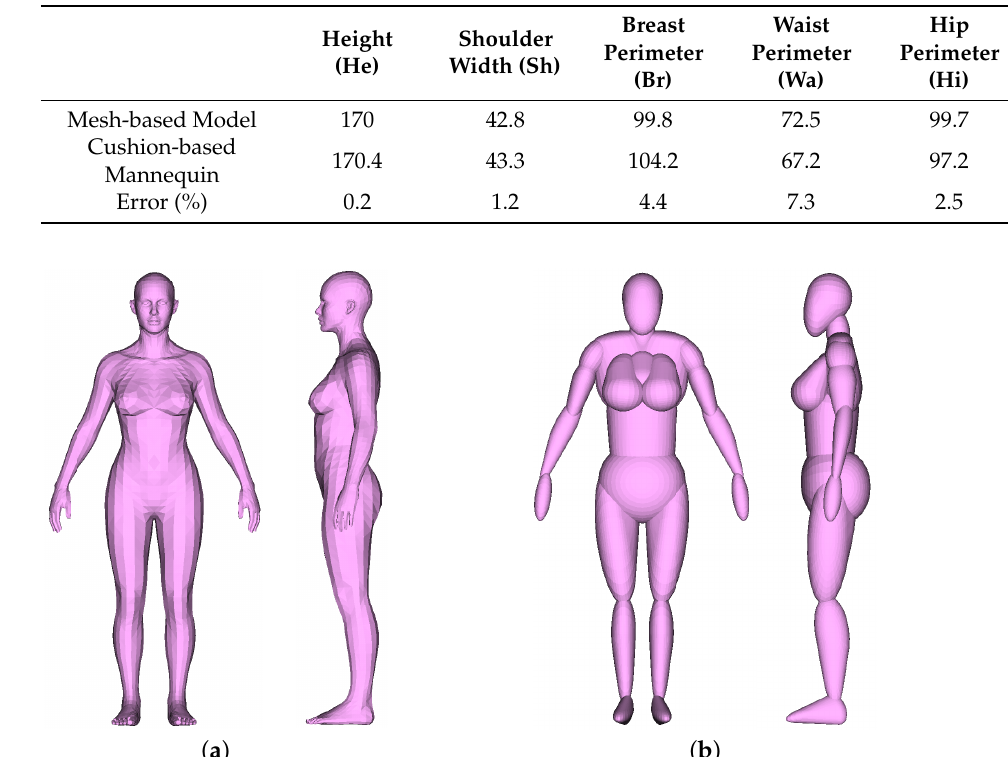
Figure 20. Visual comparison of Mesh-based Model vs. Cushion-based Mannequin syn- thesized using the measurements from the Mesh-based Model. ( a ) Mesh-based Model. ( b ) Cushion-based